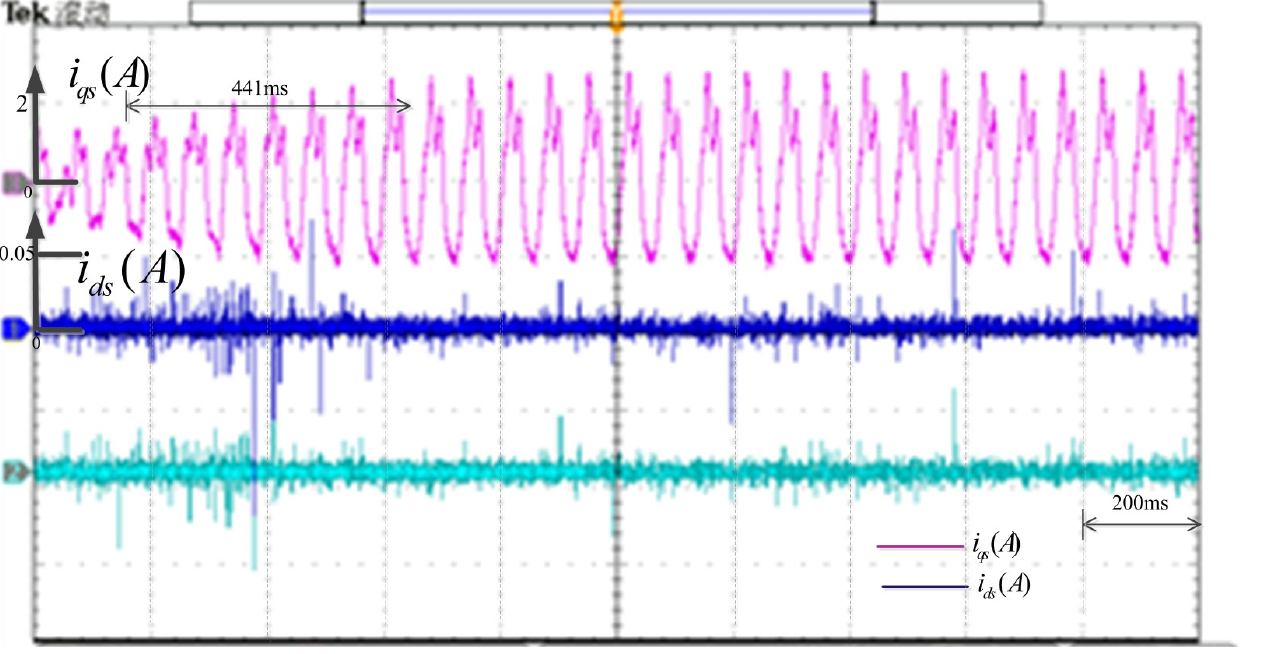
Figure 8. The validation outcomes of the traditional PI + PID control strategy for the load torque of the system abruptly changing under inductance parameters L d = 0.8ˆ L d , L q = 1.2ˆ L q . The top plot displays the q -axis stator current ( i qs ), and the bottom plot displays the d -axis current ( i ds